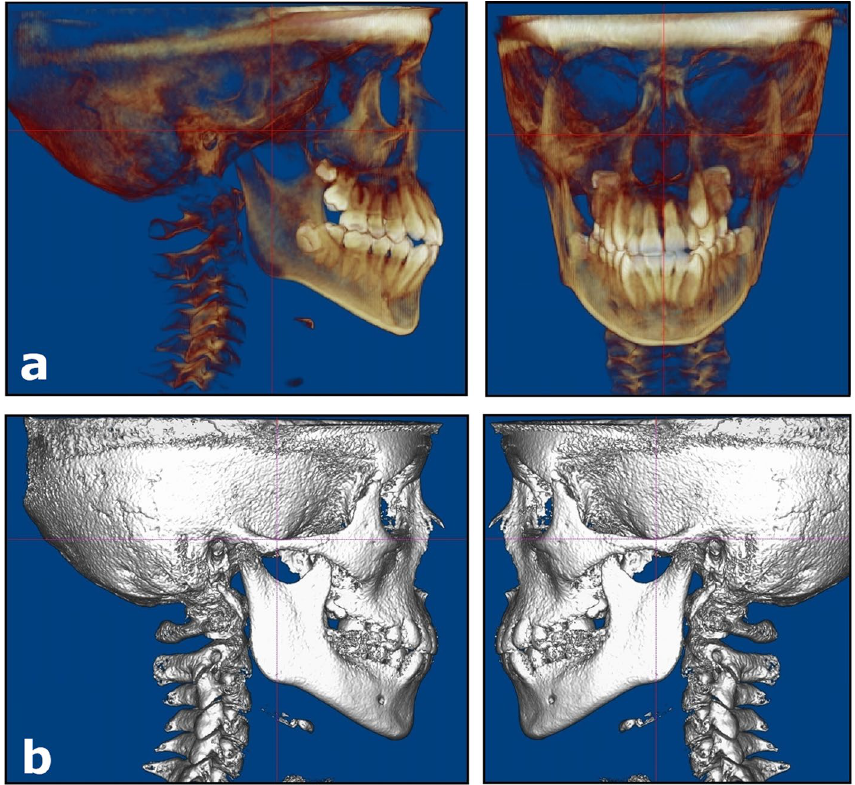
Figure 1. Orientation of the 3D reconstructions in the Dolphin Imaging software. ( a ) Translucent lateral views used to superimpose the orbital rims and the zygomatic processes of the maxilla. ( b ) Solid lateral views used to orient Frankfort Horizontal parallel to the floor.